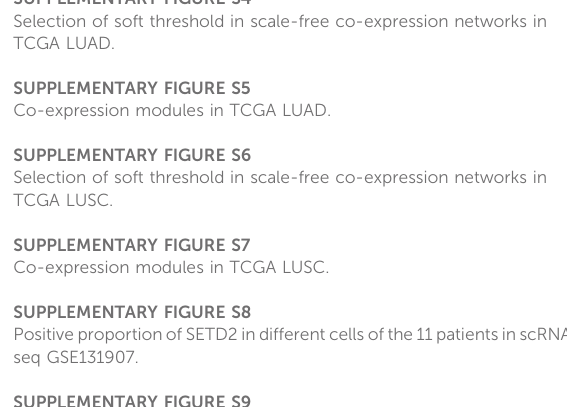
SUPPLEMENTARY FIGURE S1 Akaike information criterion of linear equation, quadratic equation and cubic equation: Radiation dose ~ gene expression. The slope of the red line is 1 and the intercept is 0. SUPPLEMENTARY FIGURE S2 Time-dependent gene clusters via Short Time-series Expression Miner. The blue line shows the changes of genes in the cluster over time. The black line is the eigenvalue of the cluster. The P value of the fi rst 11 clusters is less than 0.01. SUPPLEMENTARY FIGURE S3 The subnetworks in the 4-level biological network. (A) Subnetwork structures which were identi fi ed by MCODE app in Cytoscape (Shannon et al., 2003); (B) GO enrichment analysis of genes in the corresponding left subnetworks. SUPPLEMENTARY FIGURE S4 Selection of soft threshold in scale-free co-expression networks in TCGA LUAD. SUPPLEMENTARY FIGURE S5 Co-expression modules in TCGA LUAD. SUPPLEMENTARY FIGURE S6 Selection of soft threshold in scale-free co-expression networks in TCGA LUSC. SUPPLEMENTARY FIGURE S7 Co-expression modules in TCGA LUSC. SUPPLEMENTARY FIGURE S8 PositiveproportionofSETD2indifferentcellsofthe11patientsinscRNA- seq